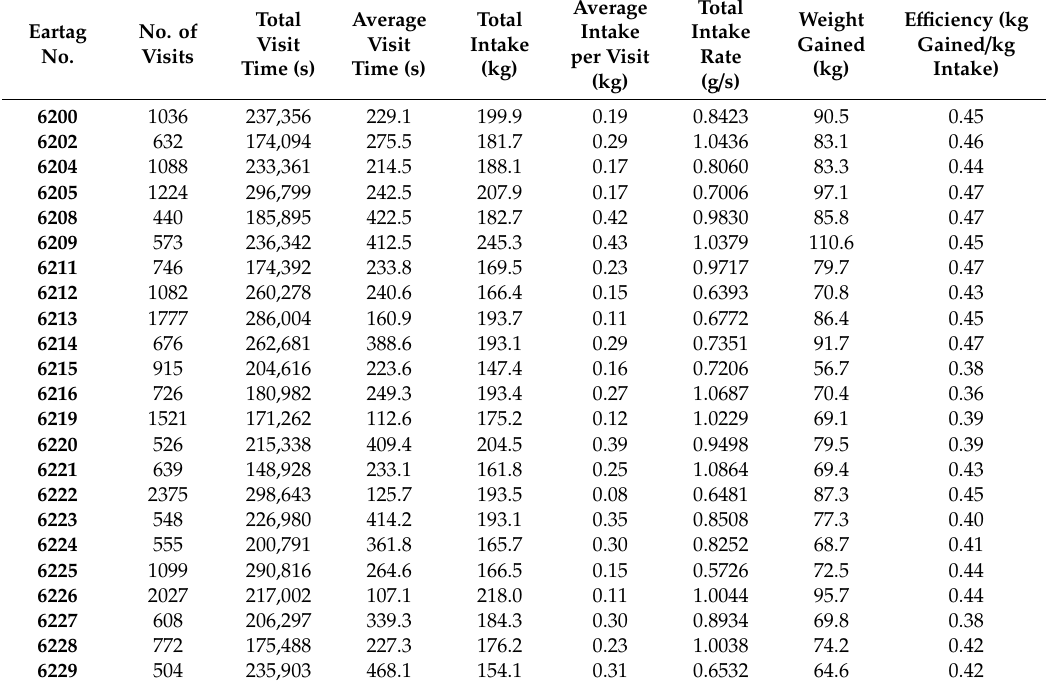
Table 3. Values recorded by the feeding station and weighing scale during the test (not considering feeding visits lower than 15 g). Eartag No.